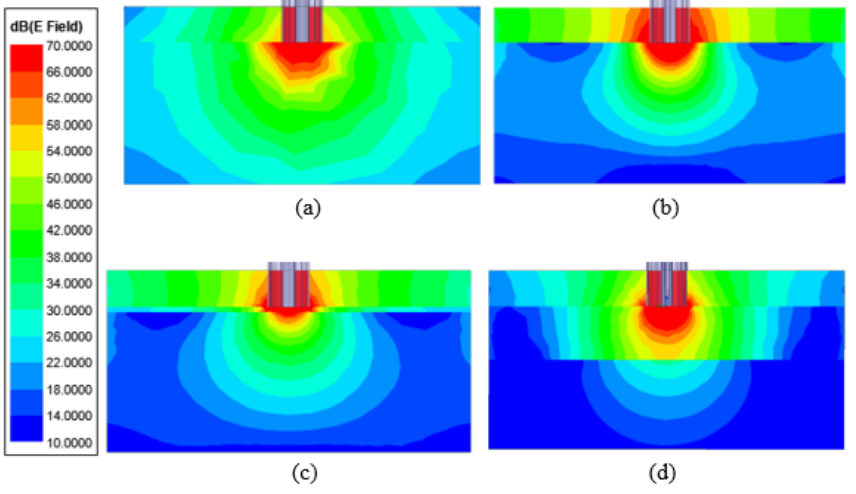
Figure 6. Electric field strength in single layer configurations ( a ) olive oil, ( b ) skin tissue, and double- layered configurations ( c ) olive oil with 0.3 mm thickness, ( d ) olive oil with 3 mm